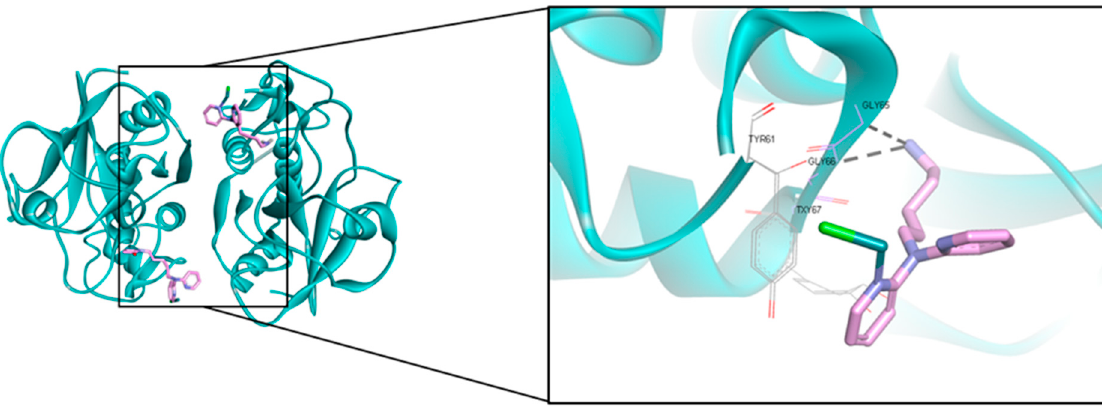
Figure 2. A homodimer of 2.1 Å resolution structure of the complex obtained by aerated overnight conjugation of [( Z 6- benzene)Ru(1-{5-[ bis (pyridin-2-yl)]pentyl}pyrrole-2,5-dione)Cl]Cl with papain. The protein is presented in a cyan ribbon and the ligand is in a pink stick model for C, and blue for N.